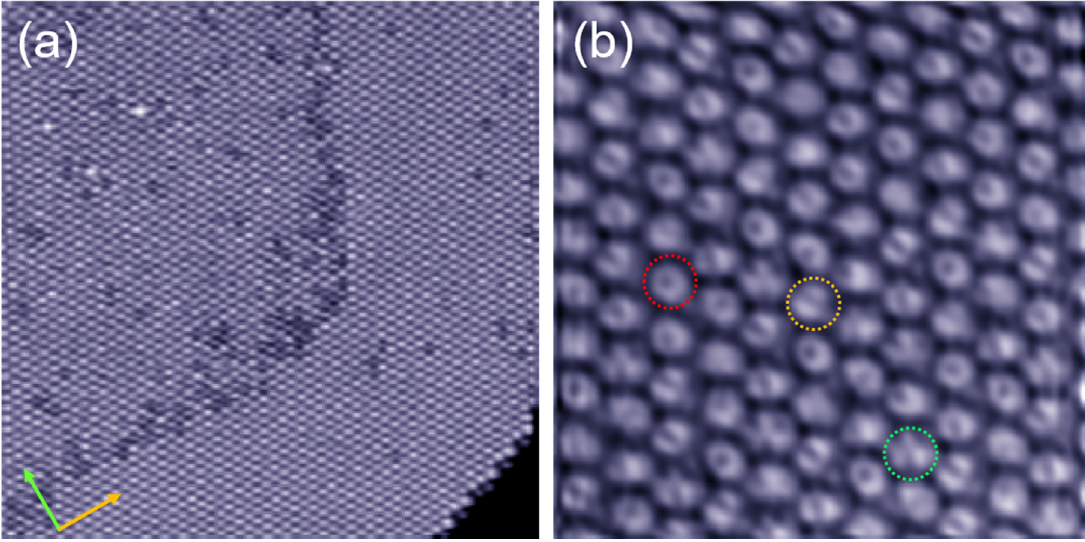
Figure 2. STM images of the (2 √ 3 × 2 √ 3) R30° domain of C 60 island on Cd (0001). ( a ) Uniform domain of the R30° with all C 60 molecules in the same contrast except a few dim molecules appeared randomly, 50 nm × 50 nm, 2.2 V, 29 pA. The green and yellow arrows mark the directions of base vector and R30° of the Cd (0001), respectively. ( b ) Close-up view of the uniform domain without any dim molecules, 10 nm × 10 nm, 1.0 V, 18 pA. The red, green, and yellow circles mark the C 60 molecules with a pentagon, hexagon, and 6:6 bond facing up, respectively.